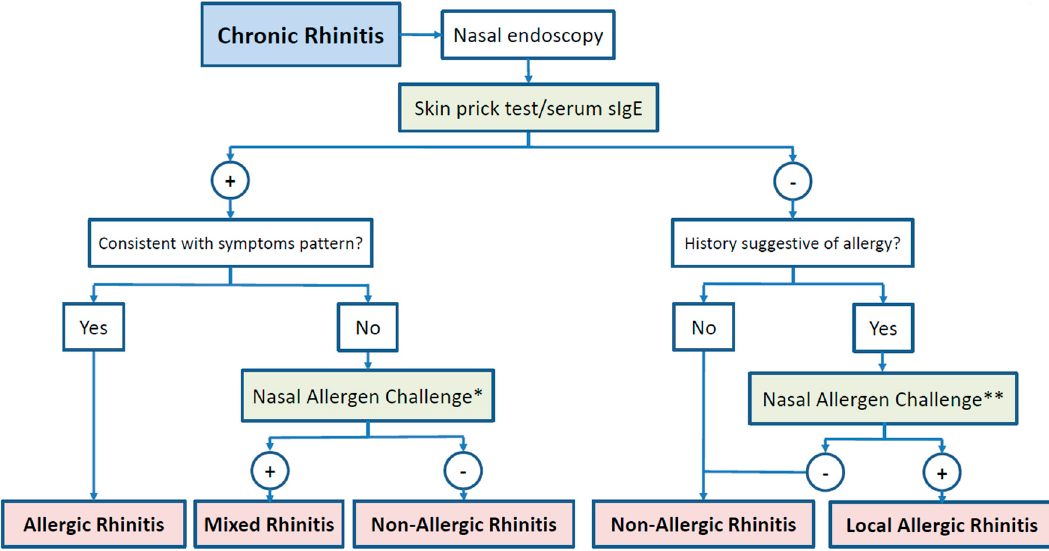
Figure 2. Diagnostic algorithm for chronic rhinitis. *: with the allergens positive in SPT / serum sIgE; **: with the suggestive allergens.